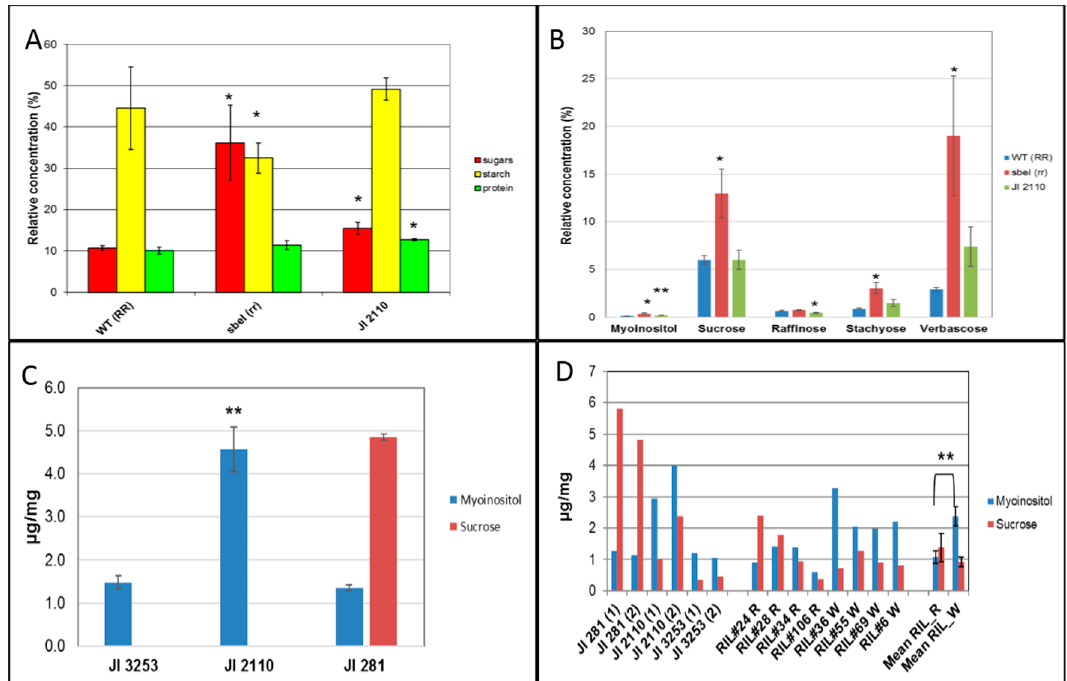
Figure 6. ( A ) Relative concentrations (% mg dry weight) of total soluble sugars, starch, and protein in cotyledons of JI 2110 in comparison with near-isogenic wild-type (WT, RR ) and wrinkled-seeded sbeI ( rr ) mutant lines. Sugars were measured relative to an internal standard, and protein relative to a standard. Bars indicate standard deviation; three replicate seeds per line. * p < 0.05, determined by t -test; ( B ) Relative concentrations (% mg dry weight) of myoinositol, sucrose, raffinose, stachyose, and verbascose in cotyledons of JI 2110 in comparison with near-isogenic wild-type (WT, RR ) and wrinkled-seeded sbeI ( rr ) mutant lines. Bars indicate standard deviation; three replicate seeds per line. * p < 0.05, ** p < 0.01, determined by t -test; ( C ) Concentrations of myoinositol and sucrose ( μ g/mg dry weight) in testas of JI 2110 in comparison with testas of the wild-type (round-seeded) genotypes, JI 281 and JI 3253. Bars indicate standard deviation; three replicate batches of testas per line. Standards of each compound enabled detection and quantification; metabolites not shown were below the lowest calibration points of the standards. ** p < 0.01, determined by t -test. (( A – C ) *, ** denote comparisons of JI 2110 or sbeI with wild-type lines); ( D ) Concentrations of myoinositol and sucrose ( μ g/mg dry weight, determined using standards of each compound) in testas of JI 2110, JI 281, JI 3253 (1, 2, two replicate seed batches in every case) and a set of white-flowered JI 281 × JI 2110 RILs (four round-seeded, R; four wrinkled-seeded, W). Mean values for the R and W RILs are shown with standard error bars. ** p = 0.01, determined by t -test of myoinositol concentration in R and W RILs.